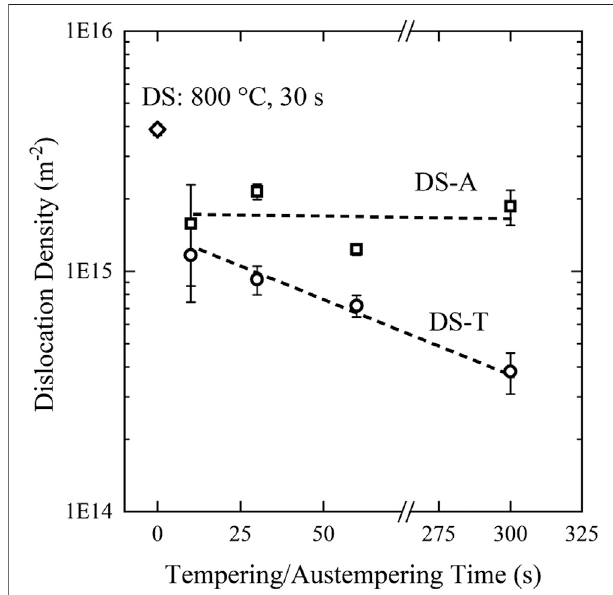
FIGURE 7 | Dislocation density as a function of tempering or austempering time for the DS-T and DS-A heat treatments, calculated using the modi fi ed Williamson – Hall methodology from XRD line scans (HajyAkbary et al., 2015). Error bars represent the standard error for an average of three measurements in each heat treatment